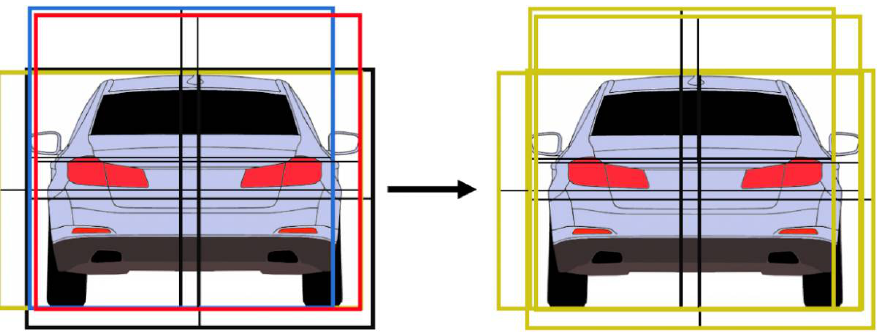
Figure 11. Re-labeling the rectangle hypothesis by the best-scored overlap.